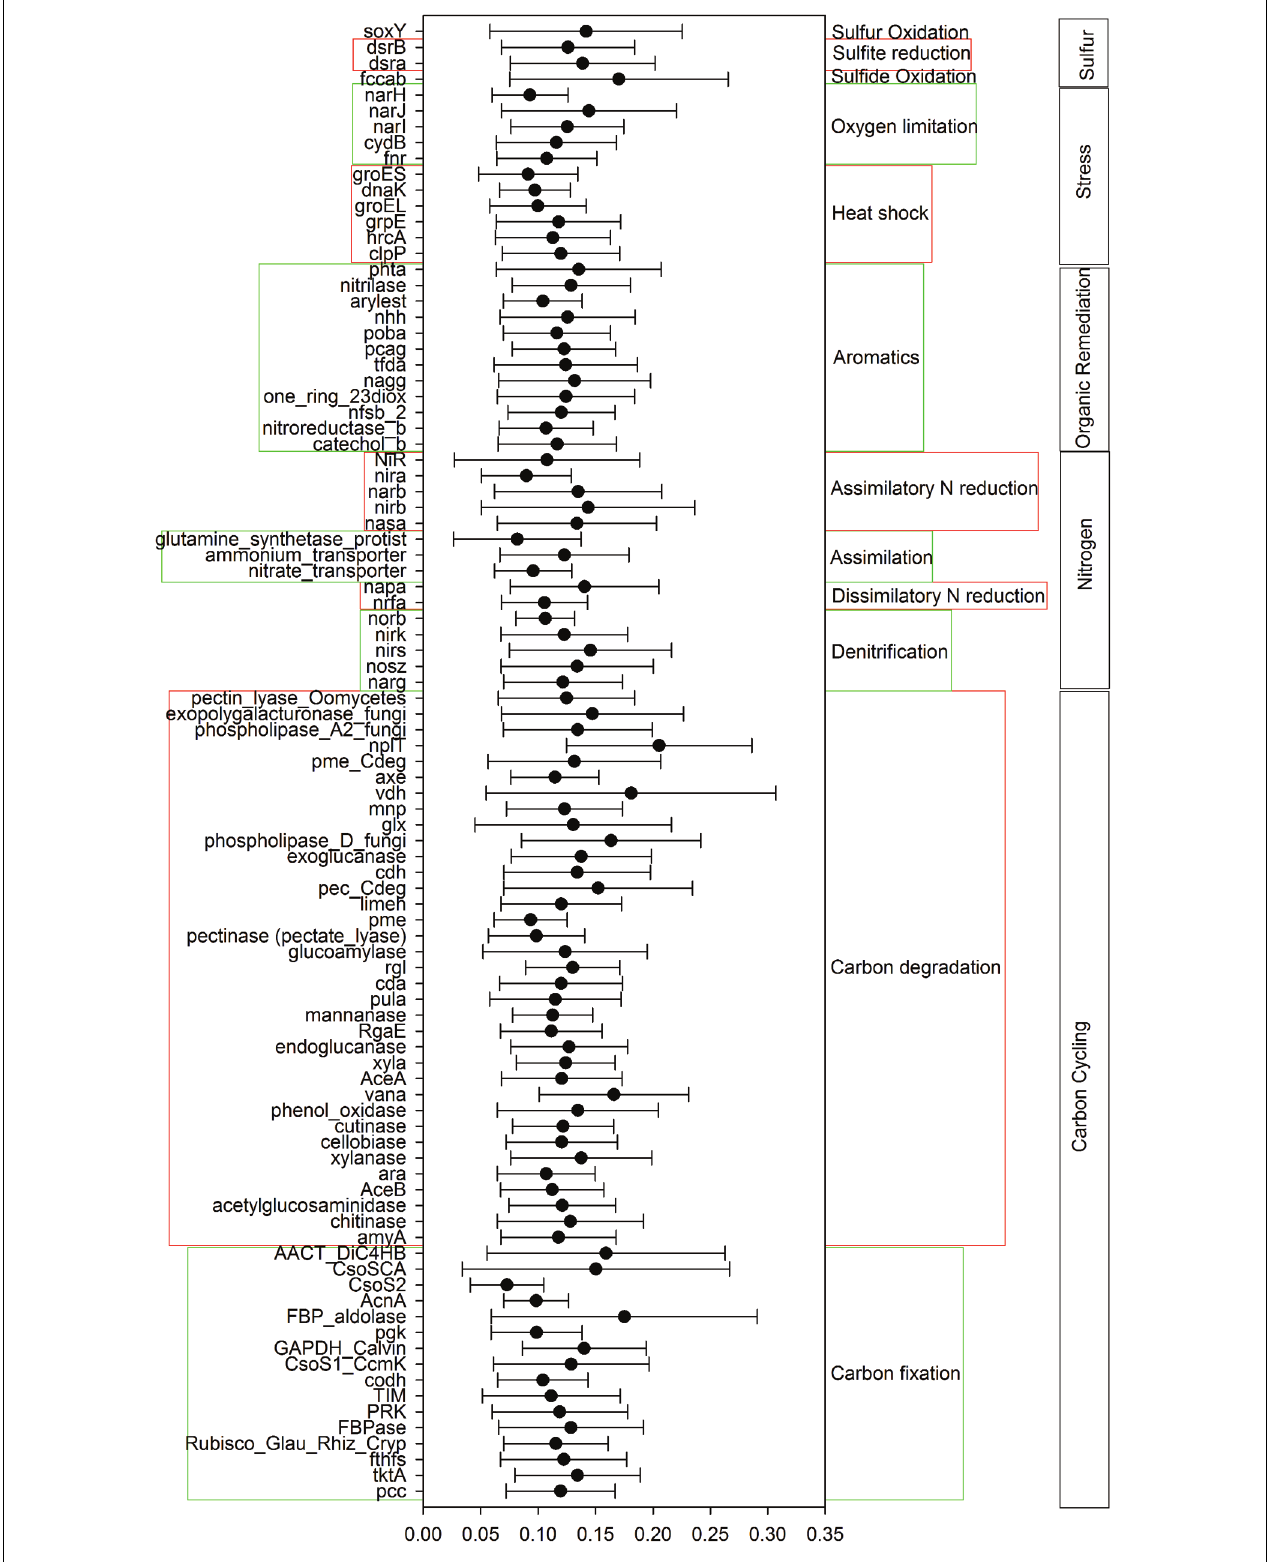
FIGURE 2 | Specific functional gene categories that exhibited significant changes in abundance from coniferous forest (1600 m) to bich forest at the treeline ecotone (1900 m). Significance was determined using the response ratio analysis at a 95% confidence interval (CI).